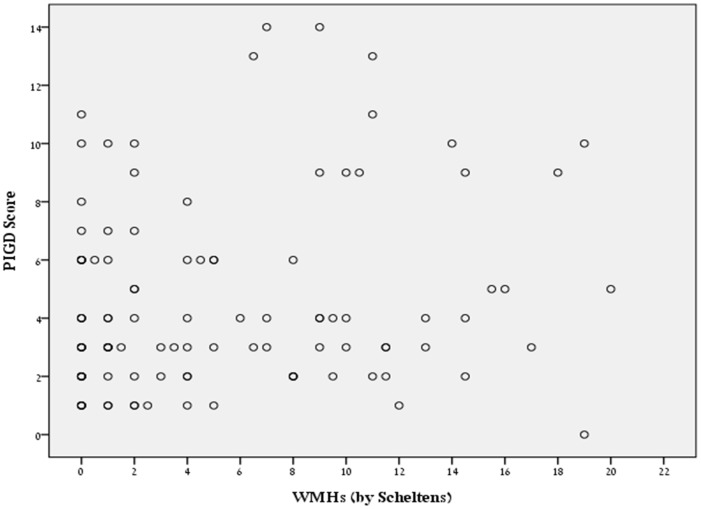
A scatter plot showing the absence of an association between the PIGD score and the total (periventricular and deep) WMHs scores, as determined using the Scheltens methods.WMHs were not correlated with PIGD symptoms.